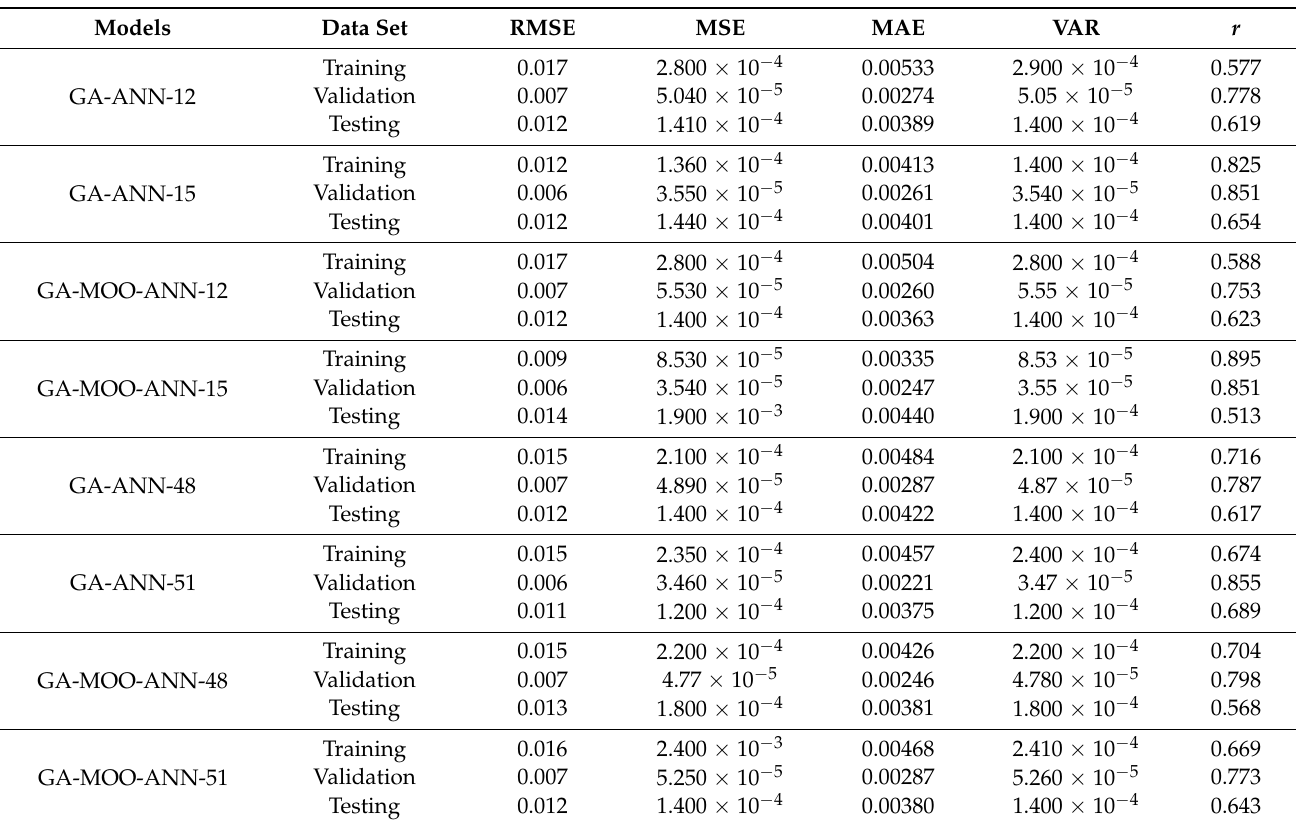
Table 6. Testing, validation, and training data error statistics for various forecasting models used for one-step-ahead forecasting of